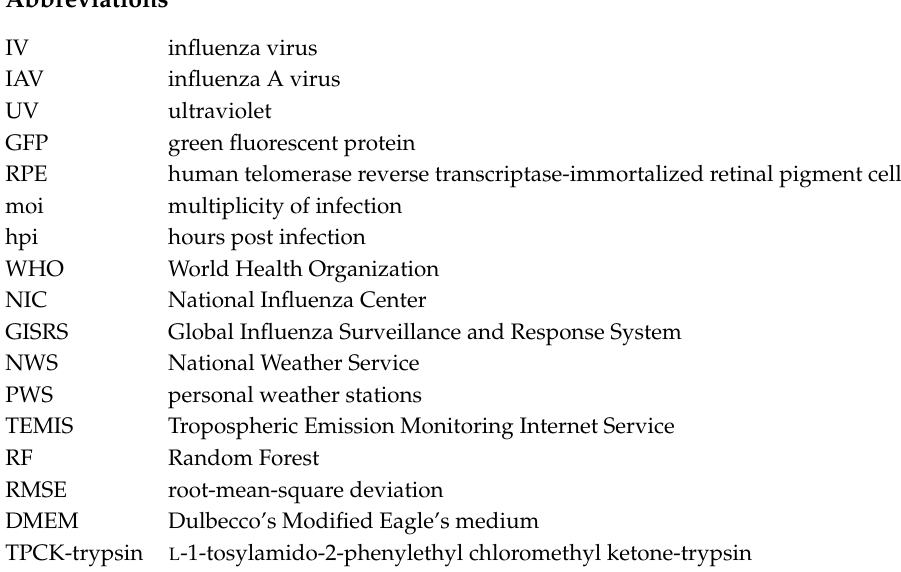
Figure S1: Weekly influenza virus activity and daily temperatures across six Northern European countries between 1 September 2017 and 31 August 2018. Figure S2: Weekly influenza virus activity and daily UV indices across six Northern European countries between 1 September 2017 and 31 August 2018. Figure S3: Graph showing relation between the number of influenza-positive specimens and median winter temperatures (2010–2018) in six Northern European countries. Figure S4: Effect of temperature and UV radiation on infectivity of influenza A/Puerto Rico/8/1934 (PR8-GFP) and A/Helsinki/P18/2009(pdm09)